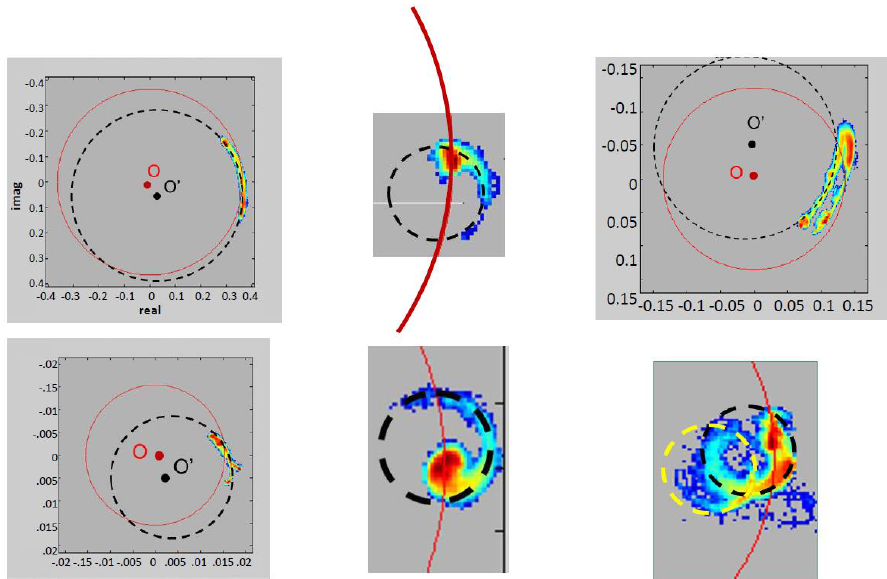
Figure 6. Complex Scatter Plots measured by vibrating targets in the presence of clutter interferences in the complex plane. The red circle is the locus of constant amplitude returns; the black circle fits the target motion.